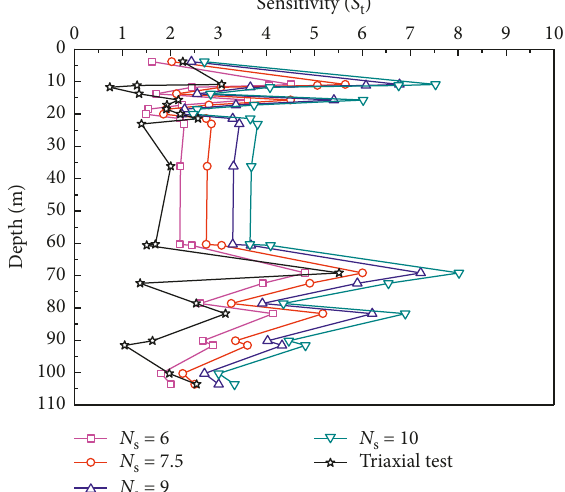
Figure 9: Revised shear strength results of undrained un- consolidated triaxial tests and CPT tests with different N kt values (clay).